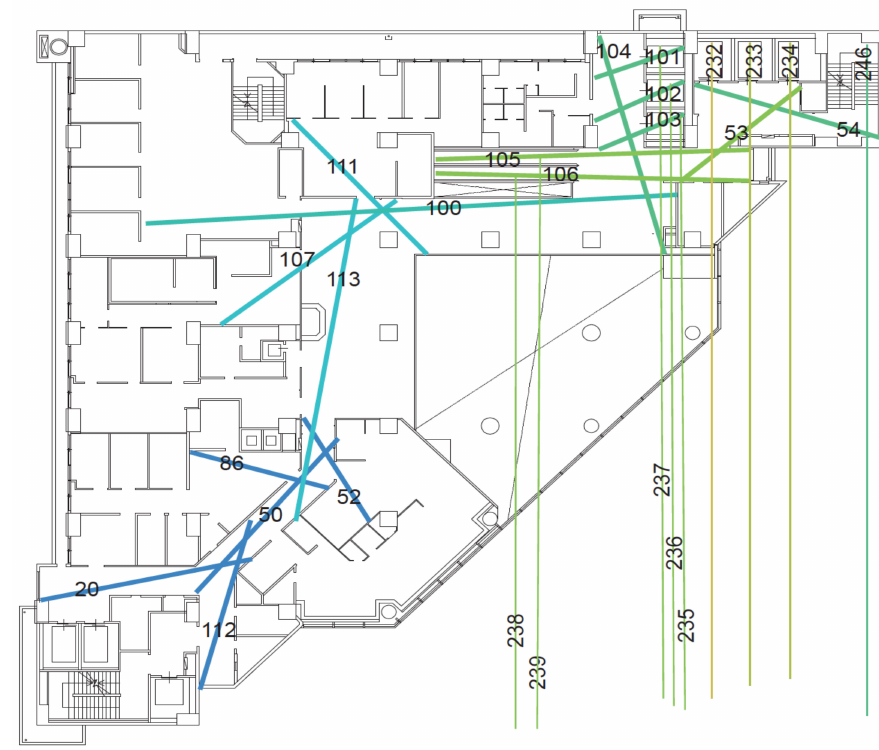
Figure 8. The axial mapping analysis of the second floor of the CCH/CKB Building. Table 4. The quantification of the dynamic syntax of major routes on the second floor of the CCH/CKB